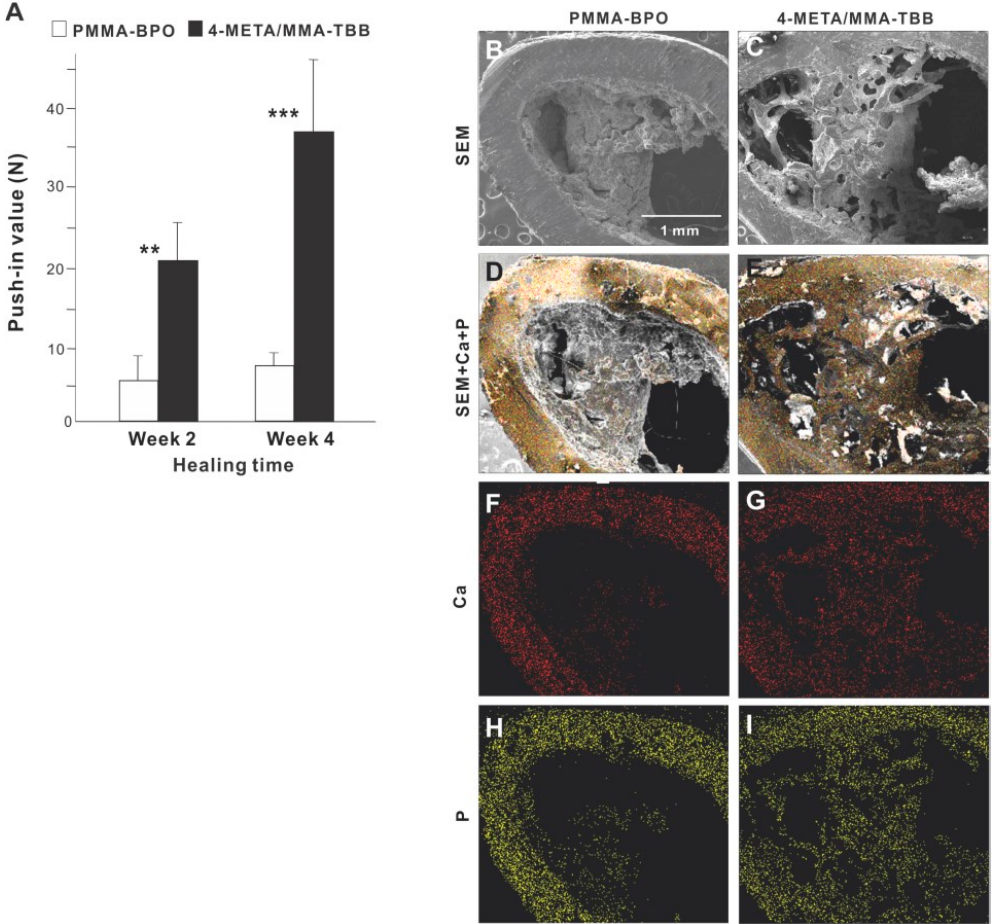
Figure 7. ( A ) The strength of bone-cement integration for two different materials. The strength of integration evaluated by the biomechanical push-in test in the rat femur model at weeks 2 and 4 of healing. ** p < 0.01, *** p < 0.001, statistically significant difference between the two materials. Tissue morphology and chemistry evaluated after push-in testing ( B – I ). Implants with cement materials were retrieved after the biomechanical push-in test and analyzed by SEM (B,C) and EDX (D–I). EDX was performed to map Ca and P elements.